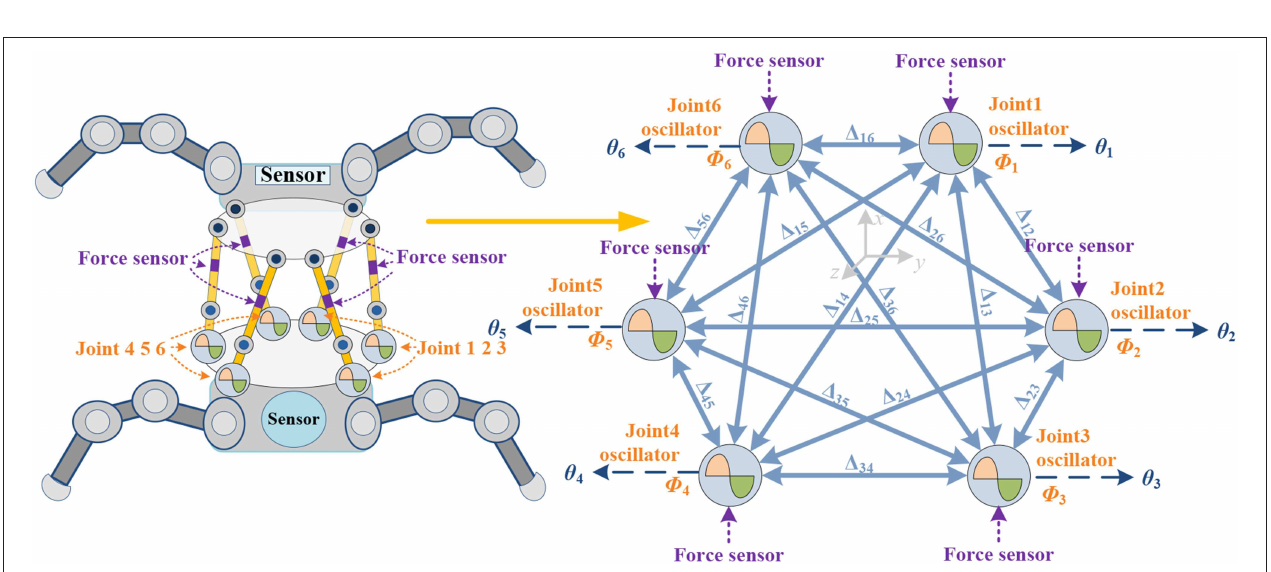
FIGURE 2 | Two-way ring architecture network. Every limb composes of 2 links, 2 spherical hinges, 1 actuator, and 1 force sensor. Φ i is denoted as oscillation phase of i th joint, θ i is the control signal of i th joint. Geometric structure is shown in Appendix ( Supplementary Material